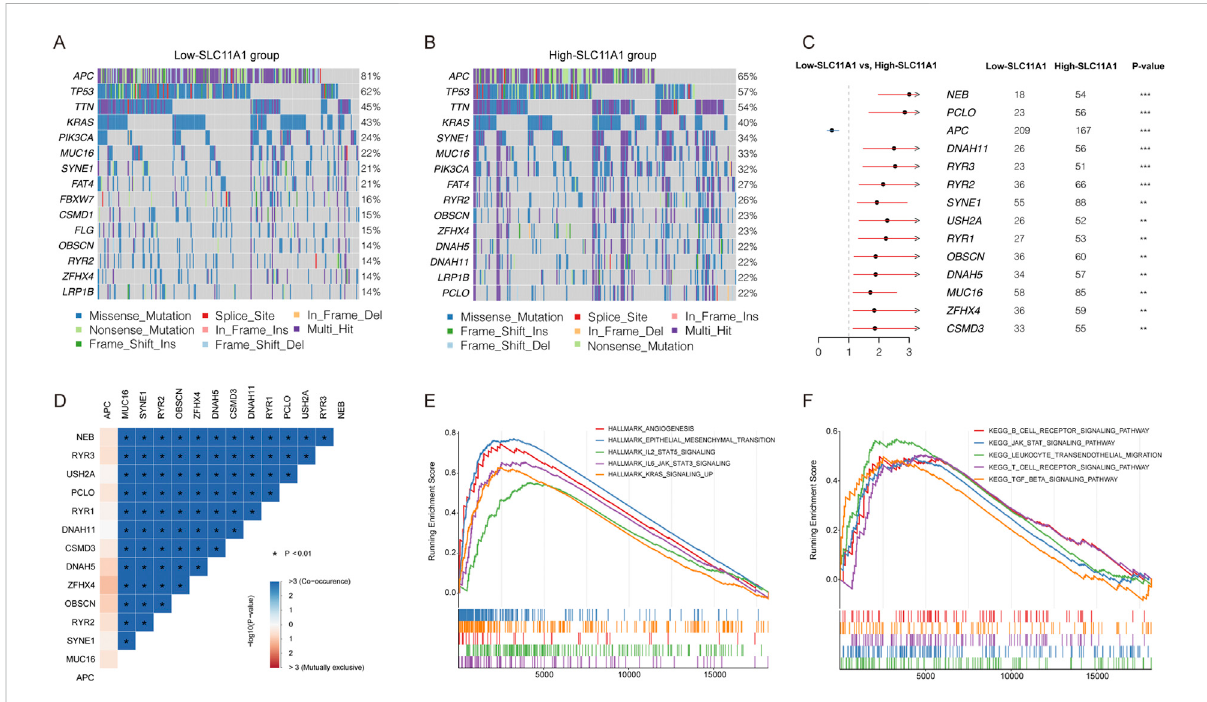
FIGURE 4 SLC11A1 expression was related with CRC mutation status. (A,B) Top 15 genes with the highest mutation frequency in the low- and high- SLC11A1 groups. (C) The forest plot illustrated the differently mutational genes between the two groups ( p < 0.01) (D) Mutation correlations of differently mutational genes. (E,F) GSEA of